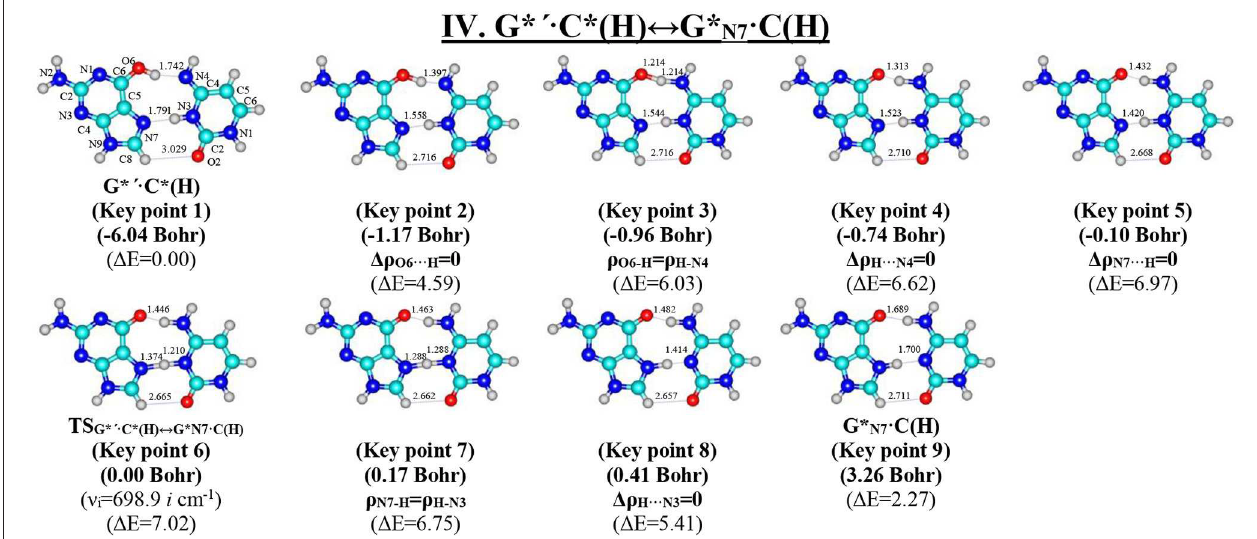
C*(H) G* N7 C(H) tautomerisation via the DPT along the IRC obtained at · ↔ ·